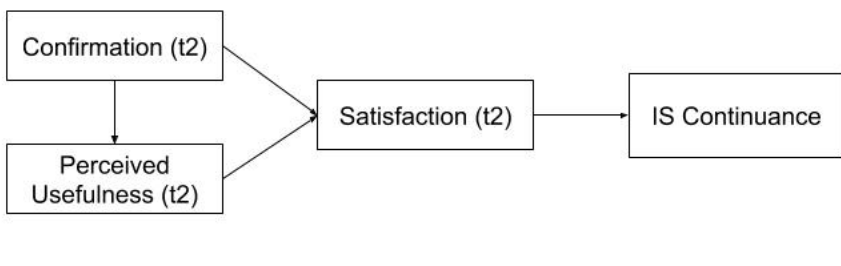
Figure 2. Expectation confirmation model of IS continuance [101].